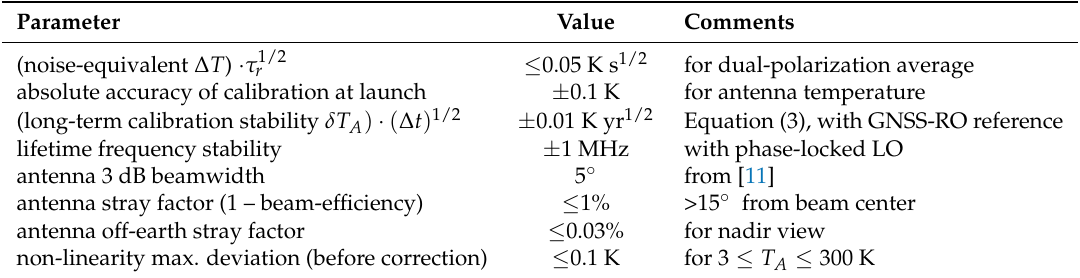
Table 1. Characteristics of a calibration-reference radiometer for 50–60